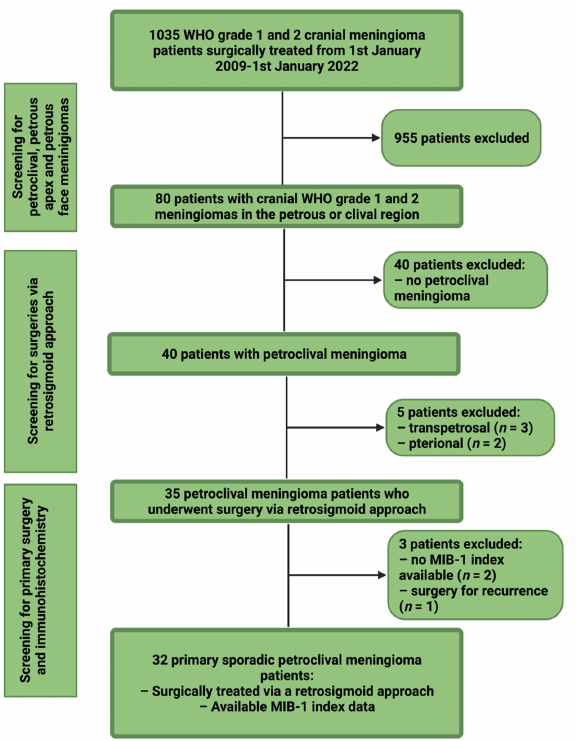
Figure 1. Flow chart illustrating the selection process of consecutive meningioma patients between 1st January 2009 and 1st January 2022. 2.2. Data Recording Clinical characteristics including age, sex, cranial nerve deficits, neurological func- tioning, body mass index (BMI), Karnofsky Performance Status (KPS), WHO grading based on neuropathological examination, extent of tumor resection based on the Simpson grading system in line with European Association of Neuro-Oncology (EANO) (Simpson grade 1–3 constitutes gross total resection, Simpson grade 4 constitutes subtotal resection, and Simpson grade 5 constitutes biopsy), and postoperative follow-up data were collected and entered into a computerized data sheet (SPSS, version 27 for Mac, IBM Corp., Armonk, NY) [23]. Abducens nerve functioning was classified using the Scott and Kraft Score [24] (complete paralysis constituting a score of 1–2, incomplete paralysis constituting a score of 3–5, normal functioning constituting a score of 6). Laboratory markers were recorded using the laboratory information system Lauris (version 17.06.21, Swisslab GmbH, Berlin,